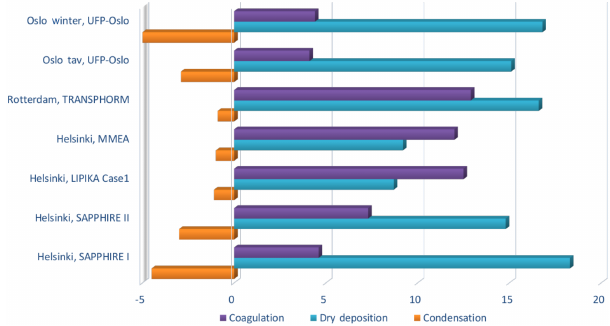
Figure 5. Contribution of aerosol processes to the percentage change of PN concentration (%) between roadside station and neighborhood environment for inefficient dispersion conditions af- ter 30min transport time in all